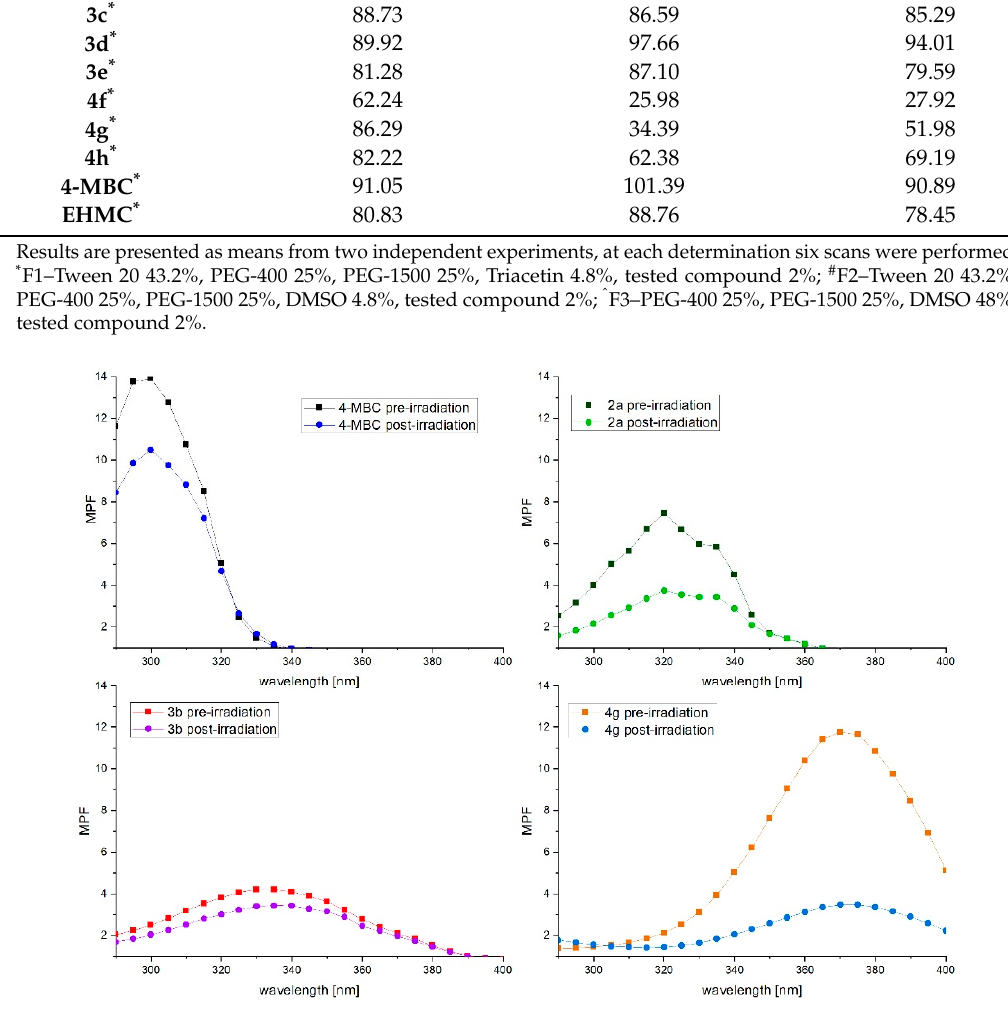
Figure 5. UV absorption spectra of tested compounds and 4-MBC pre-irradiation and after 1 hour irradiation with solar light simulator conducted at 500 W/m 2 obtained in 2% ( w/w ) macrogol formulations.